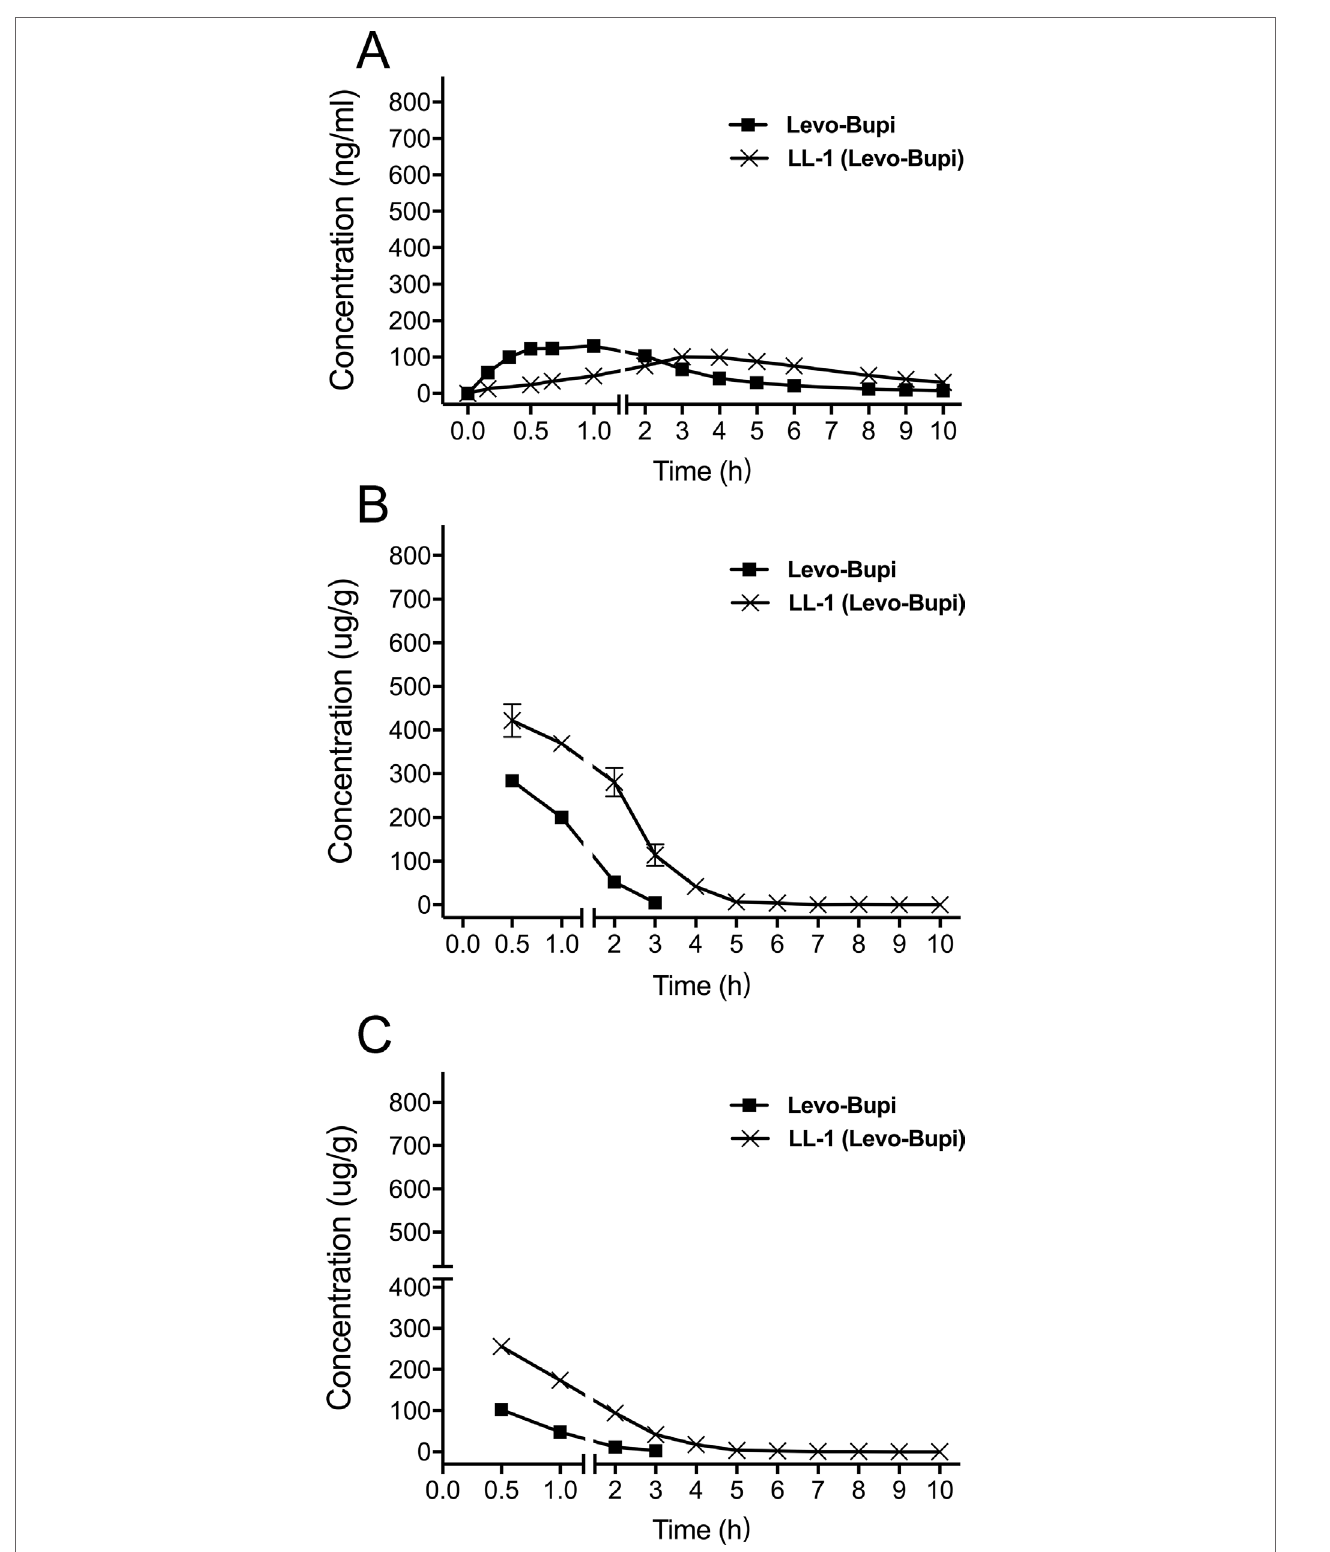
FIGURE 2 | Mean concentration-time profiles of Levobupivacaine in plasma (A) , sciatic nerve (B) , and muscle (C) after sciatic nerve block in rats. (n = 10 for plasma, and n = 5 per time point for muscle and sciatic nerve). Data are expressed as mean ± SEM. Levo-Bupi, levobupivacaine; LL-1, 35 mM QX-OH/10 mM